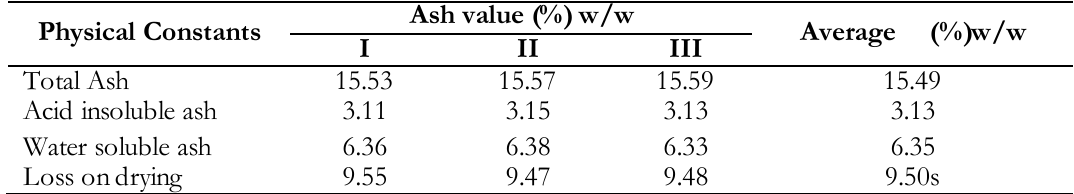
Table II. Ash values of powdered drug of Hydrolea zeylanica.